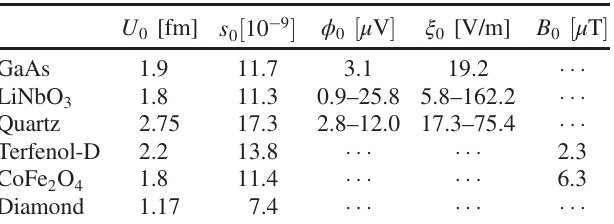
TABLE IV. Estimates for zero-point fluctuations (mechanical